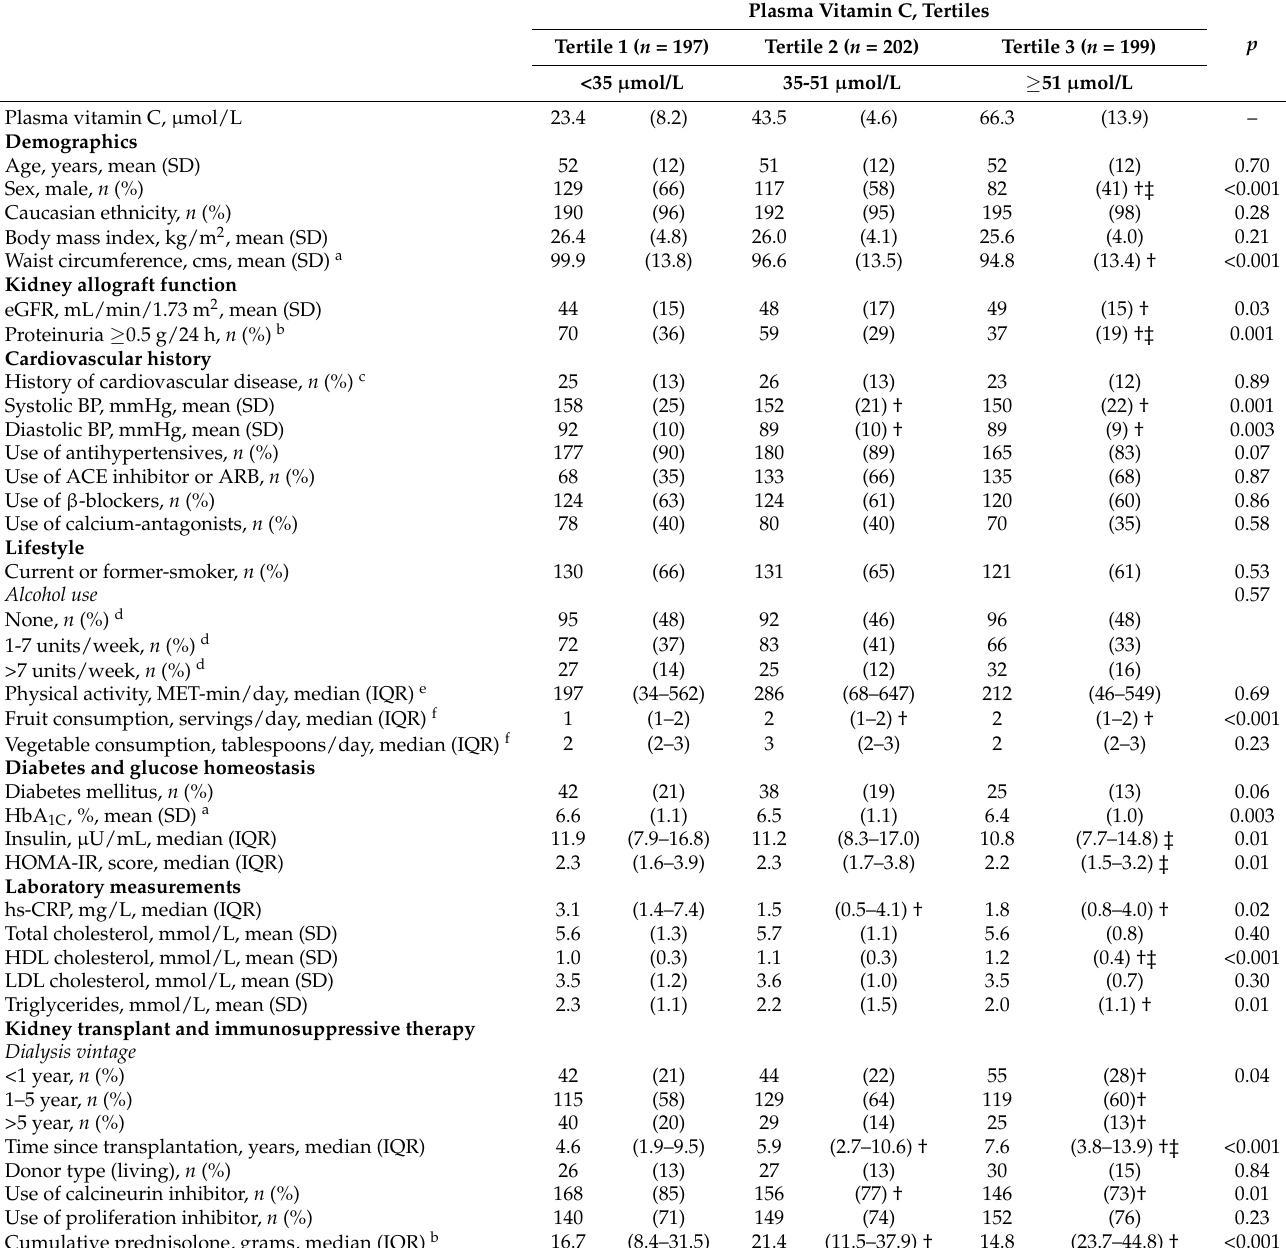
Table 1. Baseline characteristics of 598 kidney transplant recipients according to tertiles of plasma vitamin C. Plasma Vitamin C,